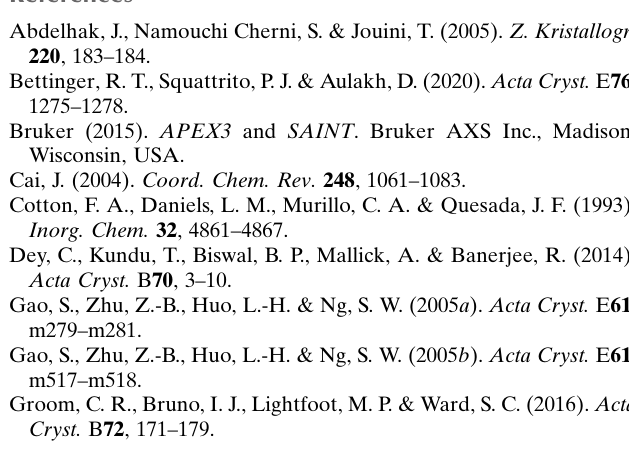
Data collection Diffractometer Bruker Duo with APEXII